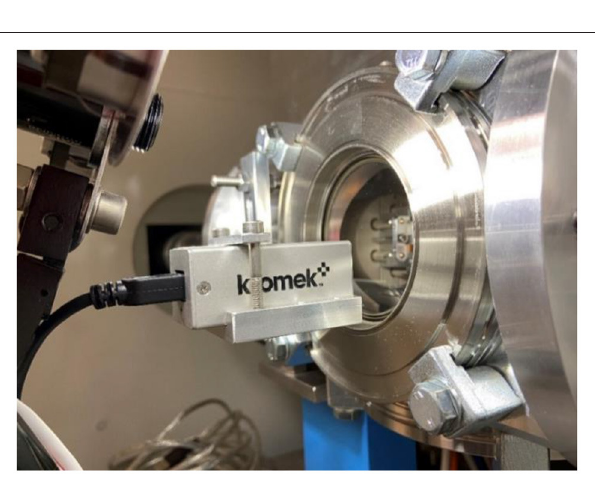
FIGURE 7 | CZT γ -ray detector installed in front of the window of the collection chamber and performing the on-line measurement of the activity being implanted on the